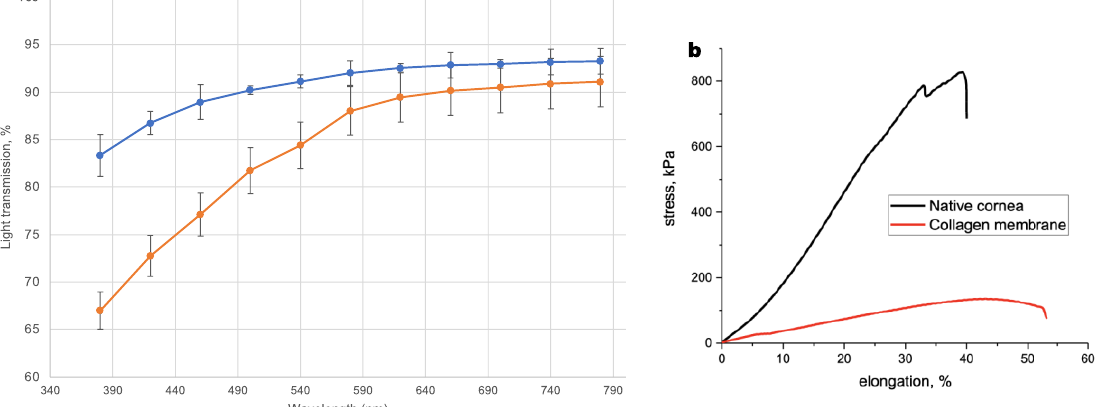
Figure 2. ( a ) Optical properties of the Viscoll collagen membrane (blue line) and stroma of human cornea (orange line). Samples thickness: 300 µm. ( b ) Characteristic stress – tension curves for Viscoll collagen membranes and human cornea samples.